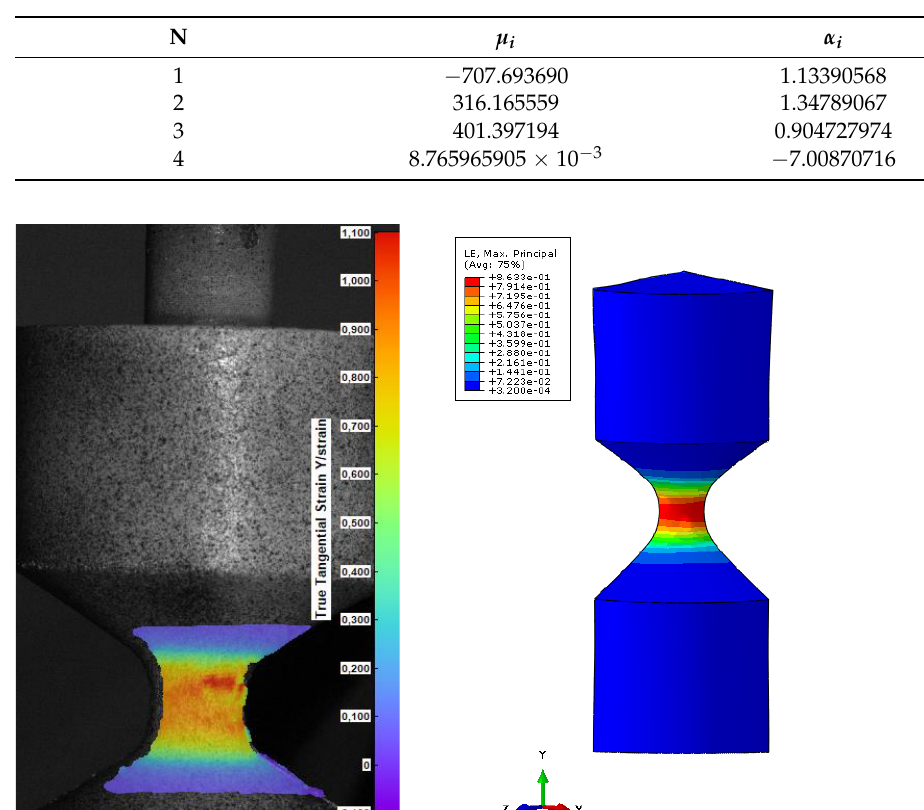
Table 3. Ogden model parameters for 90 ShA.